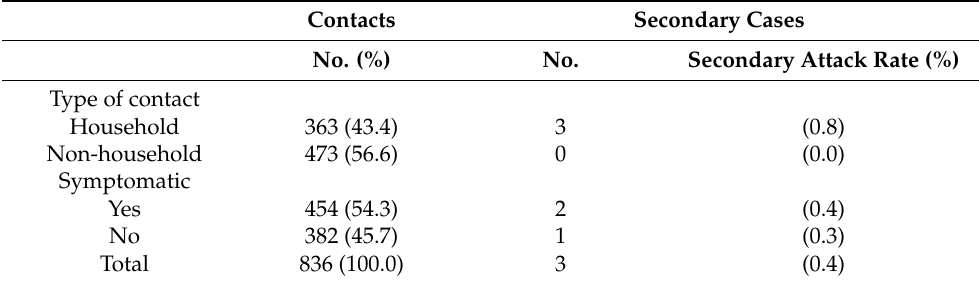
Table 3. Results of contact monitoring of individuals with confirmed re-positive SARS-CoV-2 on PCR testing after recovery from COVID-19, Republic of Korea, 2020.